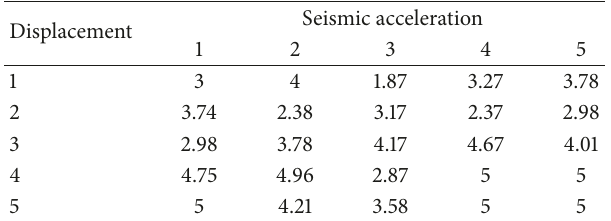
Table 4: Fuzzy control rule table of fuzzy control optimized by GA (current).